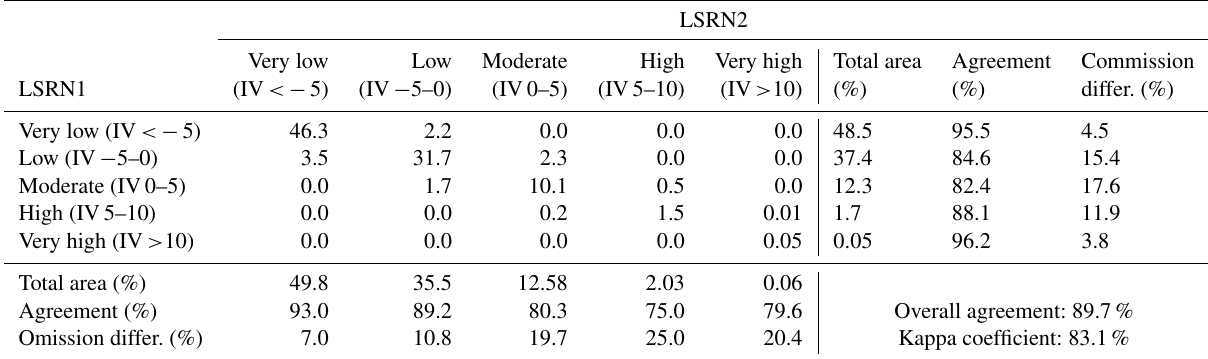
Table 5. Spatial agreement between LSRN1 and LSRN2 (percentage of road network).